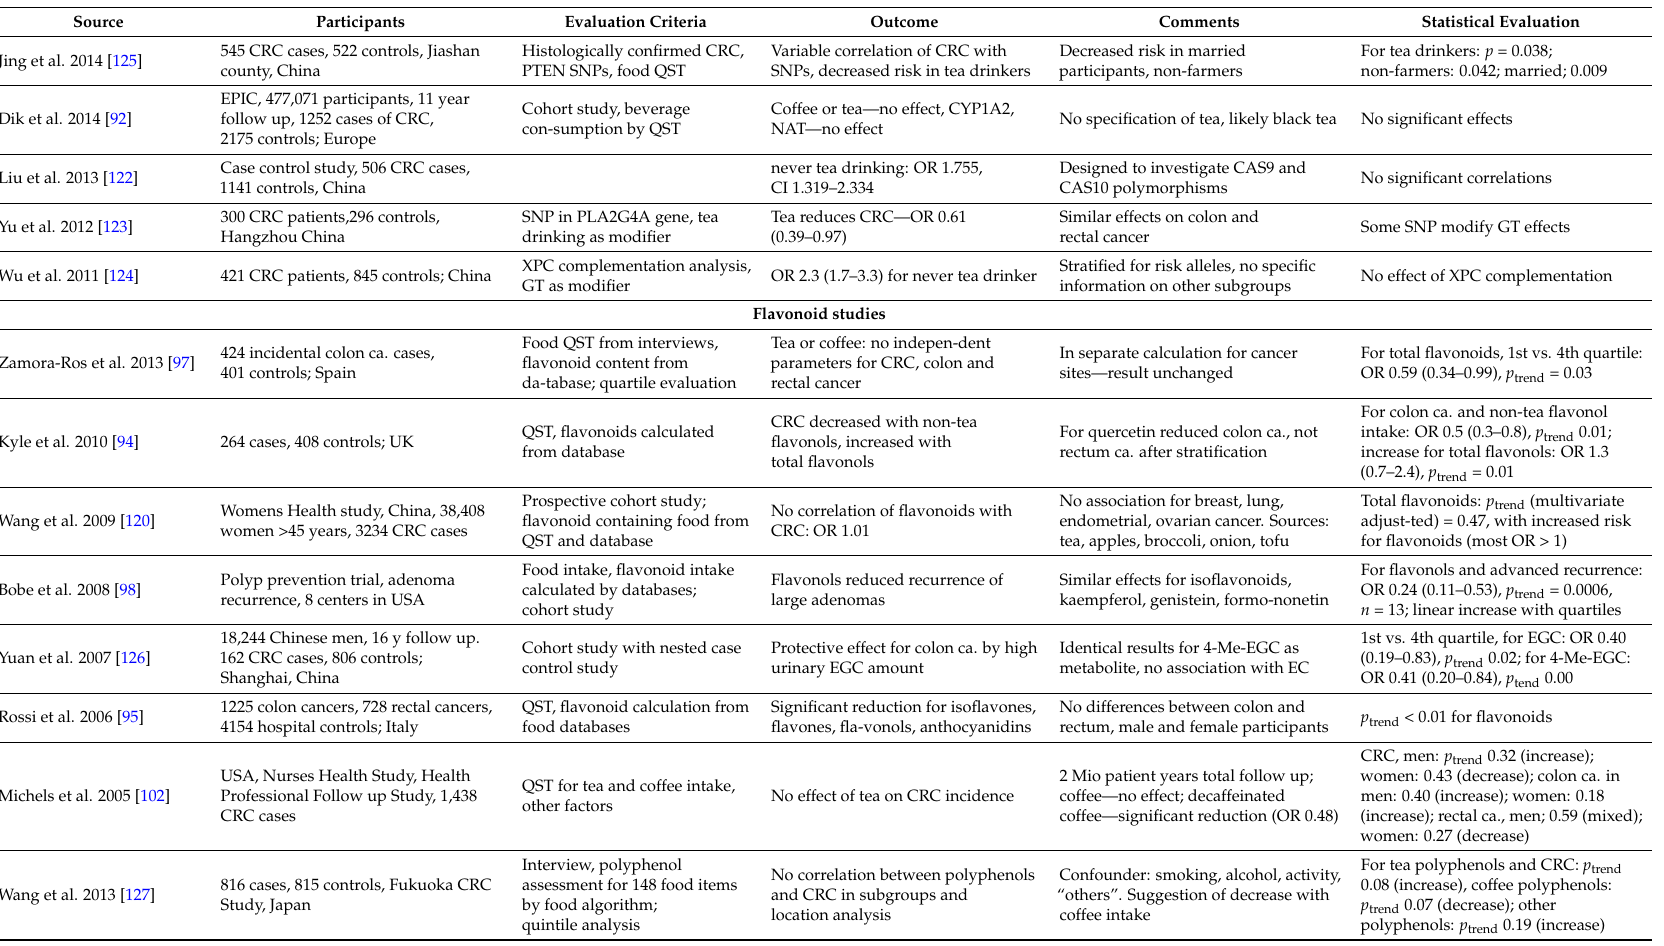
Table 3. Evidence for GT flavonoids, contribution of genetic factors and colorectal carcinoma